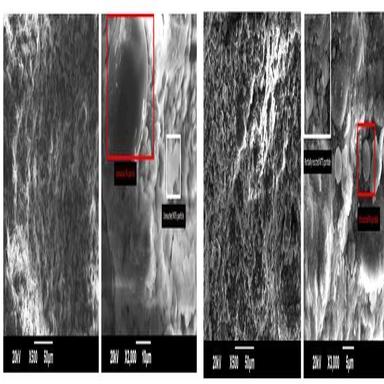
SEM images for the CLSM mixtures with 0.65 w/b, A of 5%, and varying WTS content levels.